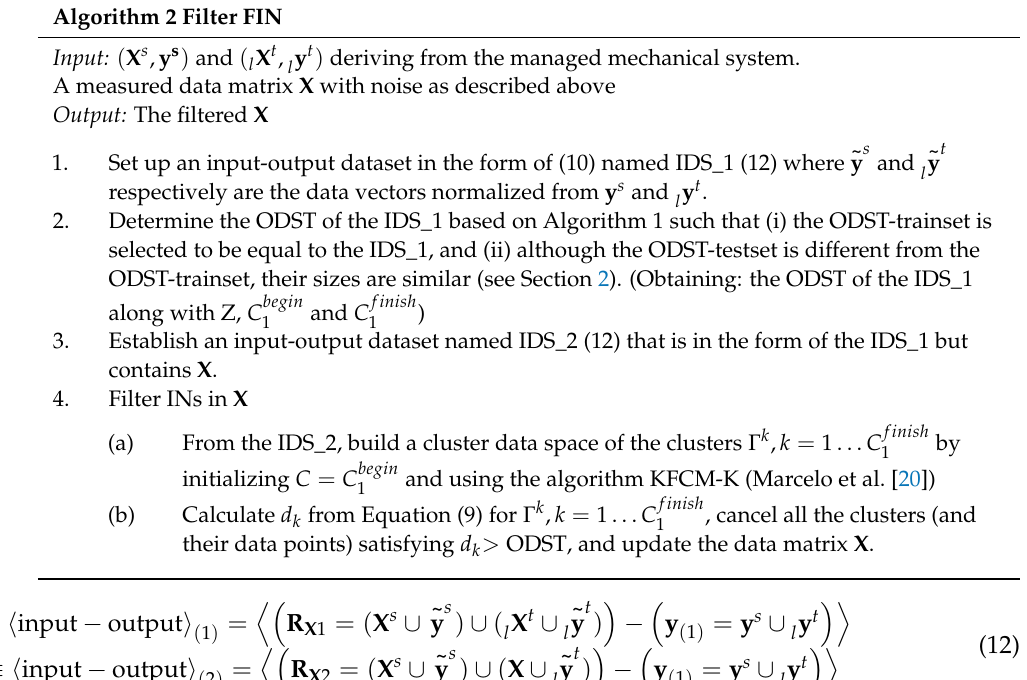
Algorithm 2 Filter